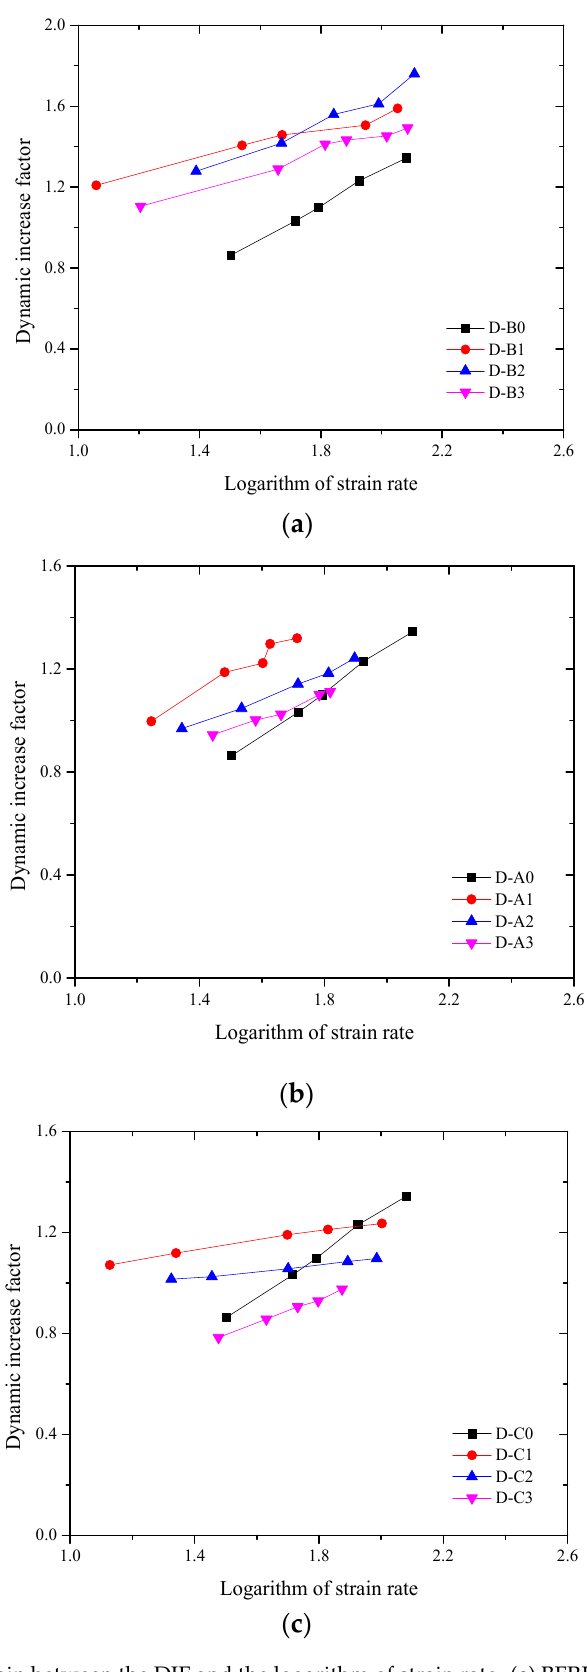
Figure 11. Relationship between the DIF and the logarithm of strain rate. ( a ) BFRP-confined specimens; ( b ) AFRP-confined specimens; and ( c ) CFRP-confined specimens.